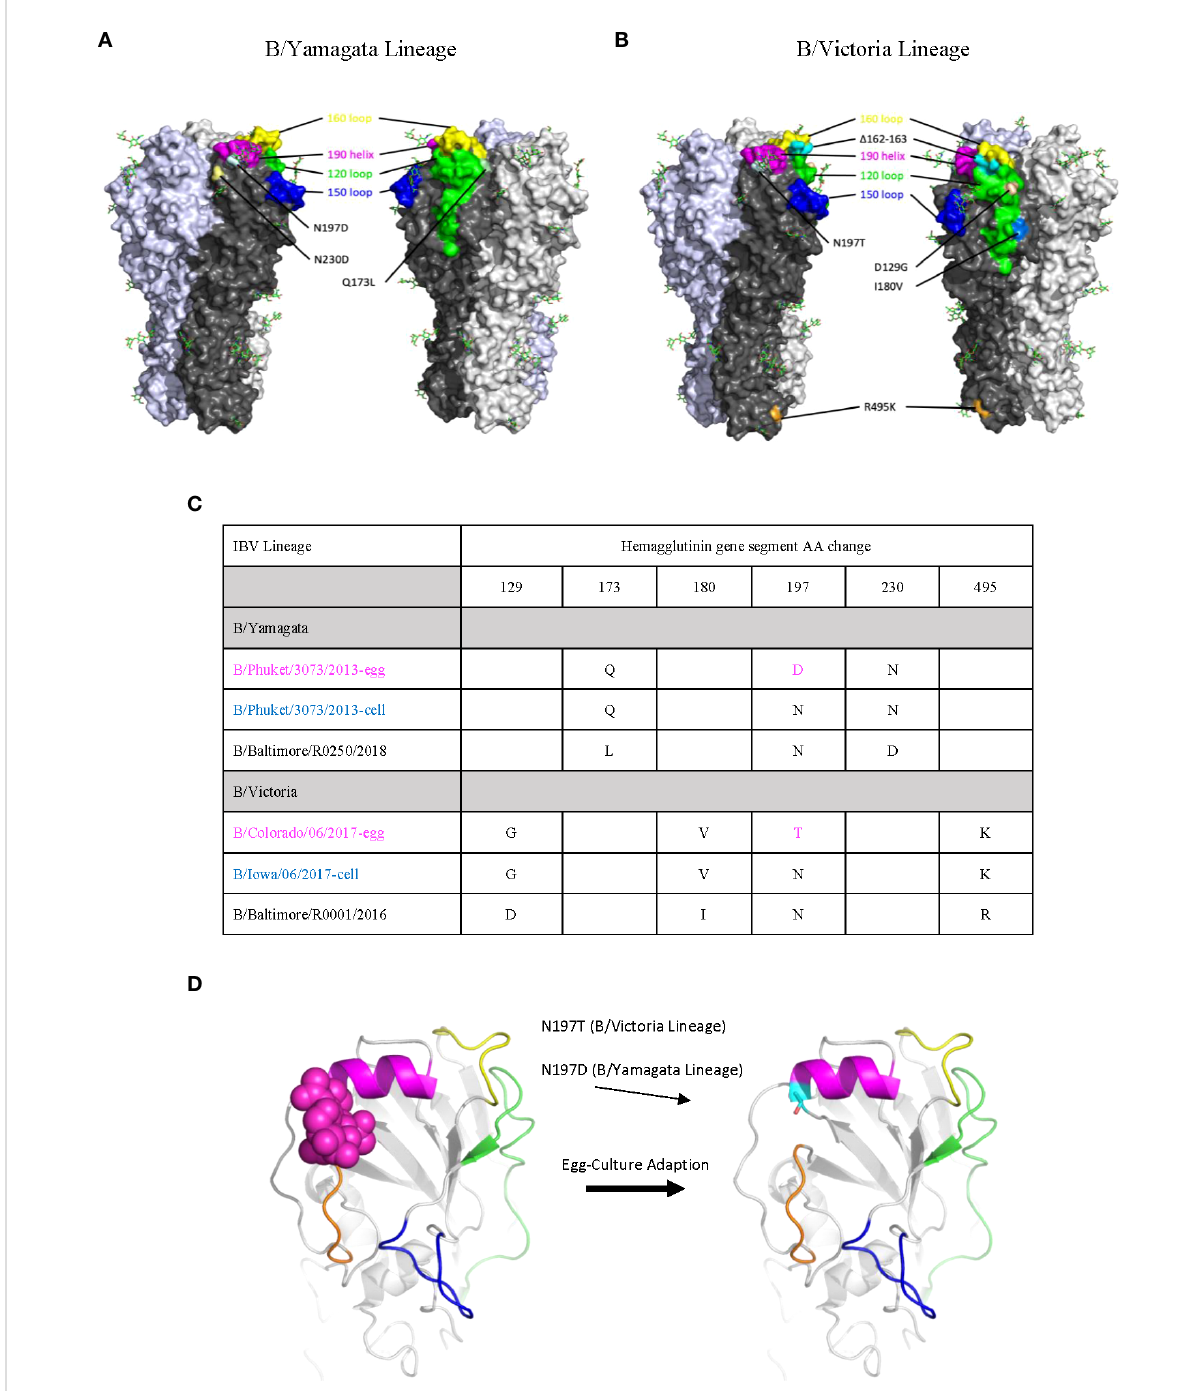
FIGURE 1 Sequence Analysis of Egg Adapted Vaccine Viruses show loss of Glycosylation Site at Position 197. (A, B) All mutations on the HA surface of egg-cultured vaccine and cell-cultured vaccine strains from the circulating strain in both B/Yamagata (A) and B/Victoria (B) lineages are mapped on the model. A mutation V252M is not shown on the model as the residue is inside the HA trimer structure. The known antigenic sites of IBV are highlighted. The 120 loop is shown in green, the 150 loop is shown in blue, the 160 loop is shown in yellow and the 190 helix is shown in violet. The crystal structure of HA of B/Brisbane/06/2008 was used for modeling and amino acid numbering. (C) Sequence alignment of circulating viruses, egg adapted vaccine strains and cell cultured strains shown. (D) Model of HA detailing egg adapted amino acid change leading to loss of a glycosylation